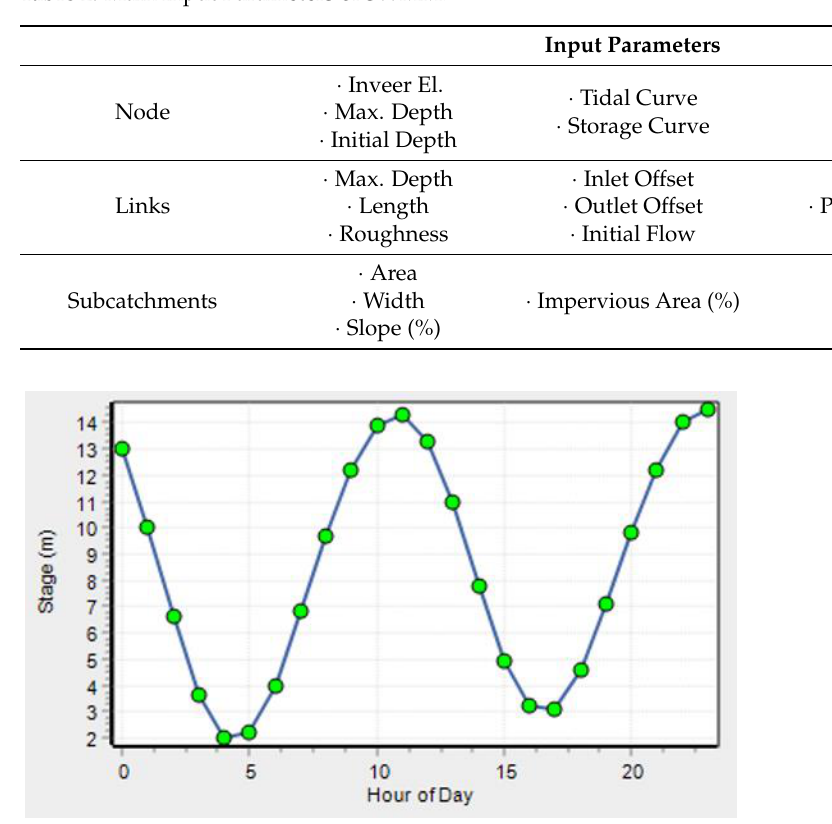
Figure 4. Average tidal curve of Suyeong bay entered in SWMM.